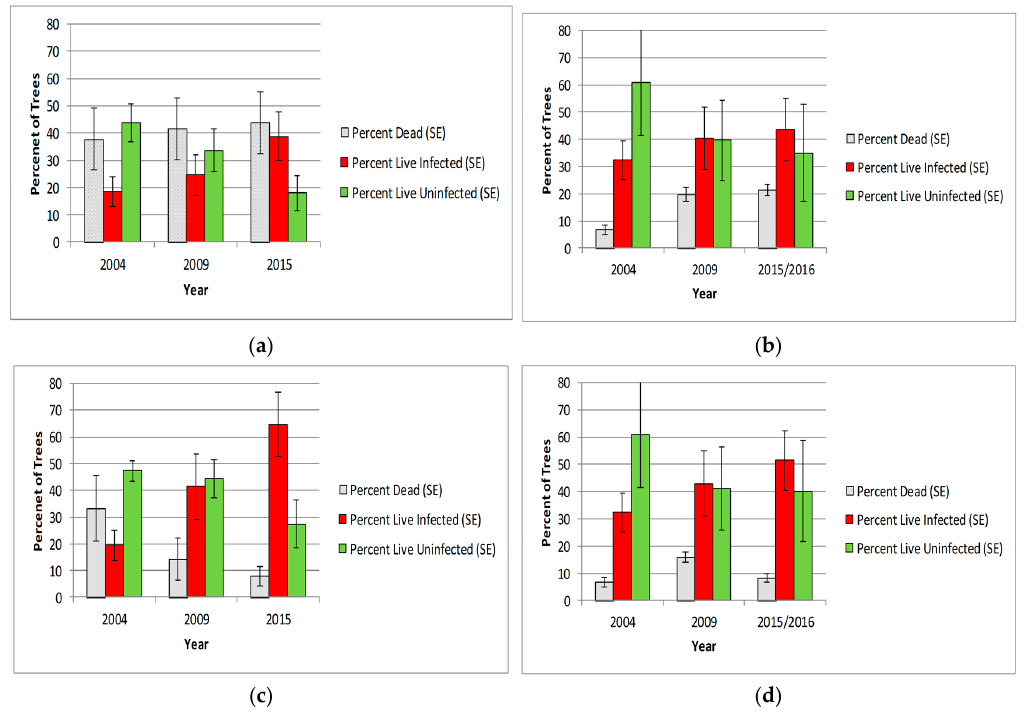
Figure 3. Percent of whitebark pine trees that were dead, WPBR infected live, and uninfected live trees (and standard error within park) in Mount Rainier National Park and North Cascades National Park Service Complex in 2004, 2009, and 2015/2016. Figures ( a ) and ( b ) are cumulative calculations in ( a ) Mount Rainier and ( b ) North Cascades and figures ( c ) Mount Rainier and ( d ) North Cascades are progressive (i.e. previously dead trees were removed from 2009 and